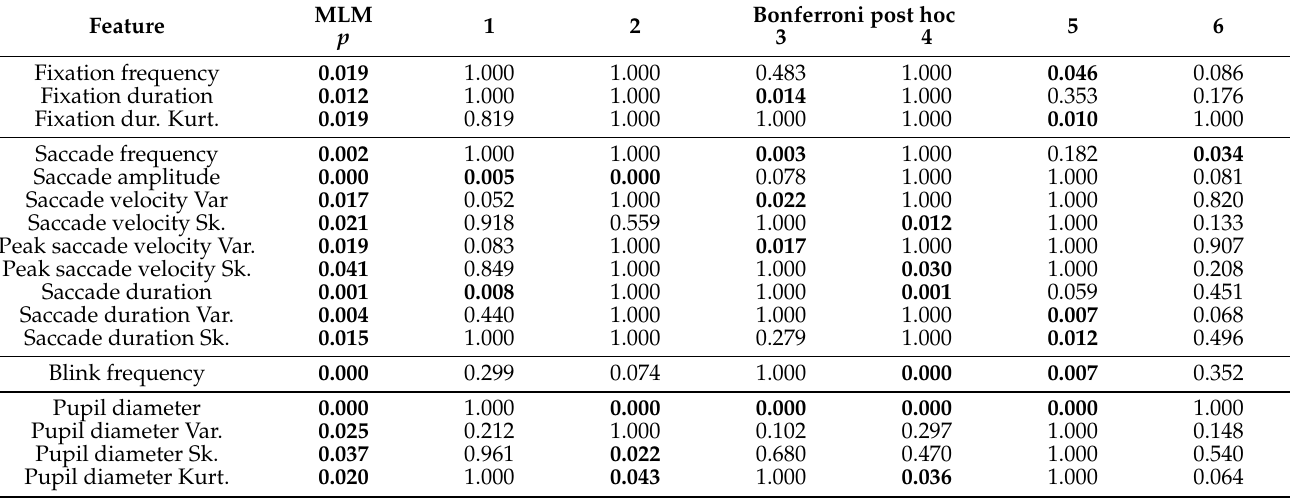
Table 8. Results of Mixed Linear Model (MLM) and post hoc tests for emotion classes. MLM Fixation frequency